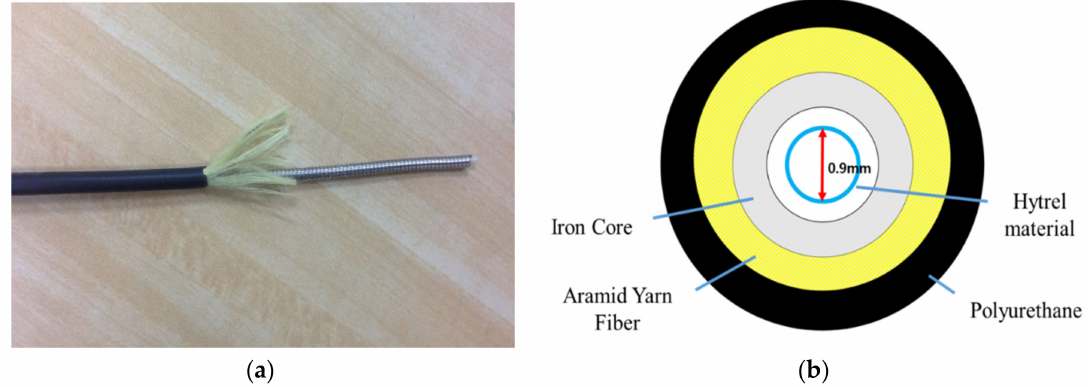
Figure 4. ( a ) Developed cable of the FBG sensors for sea water; and ( b ) cross-section of the cable.